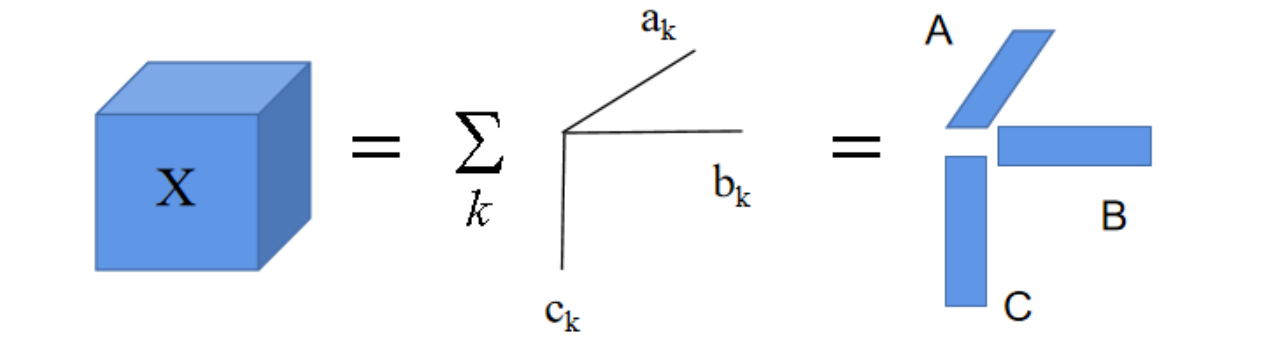
Figure 2. Procedure for Parallel Factor Decomposition.